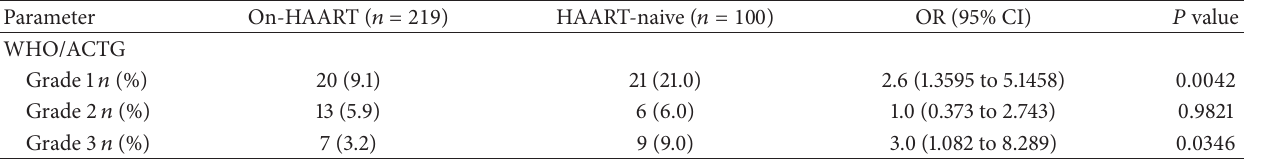
Table 7: Anaemia and associated risks, amongst the study